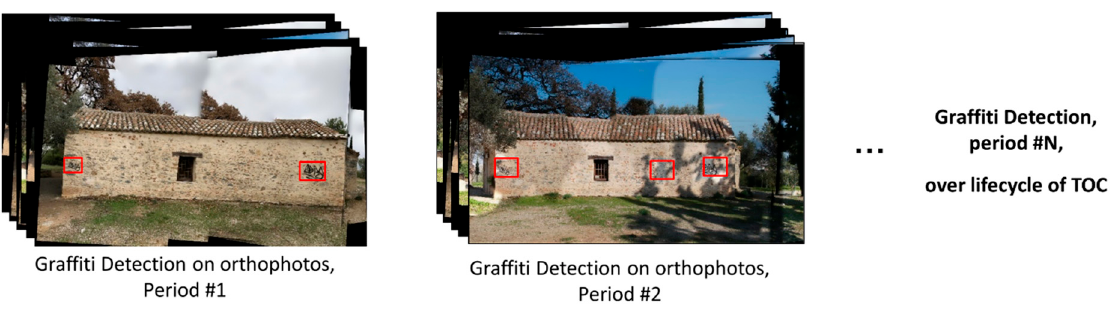
Figure 5. The robust graffiti detector was applied to each of the orthophotos, providing an overall presence of graffiti, including the location and size of each mark.